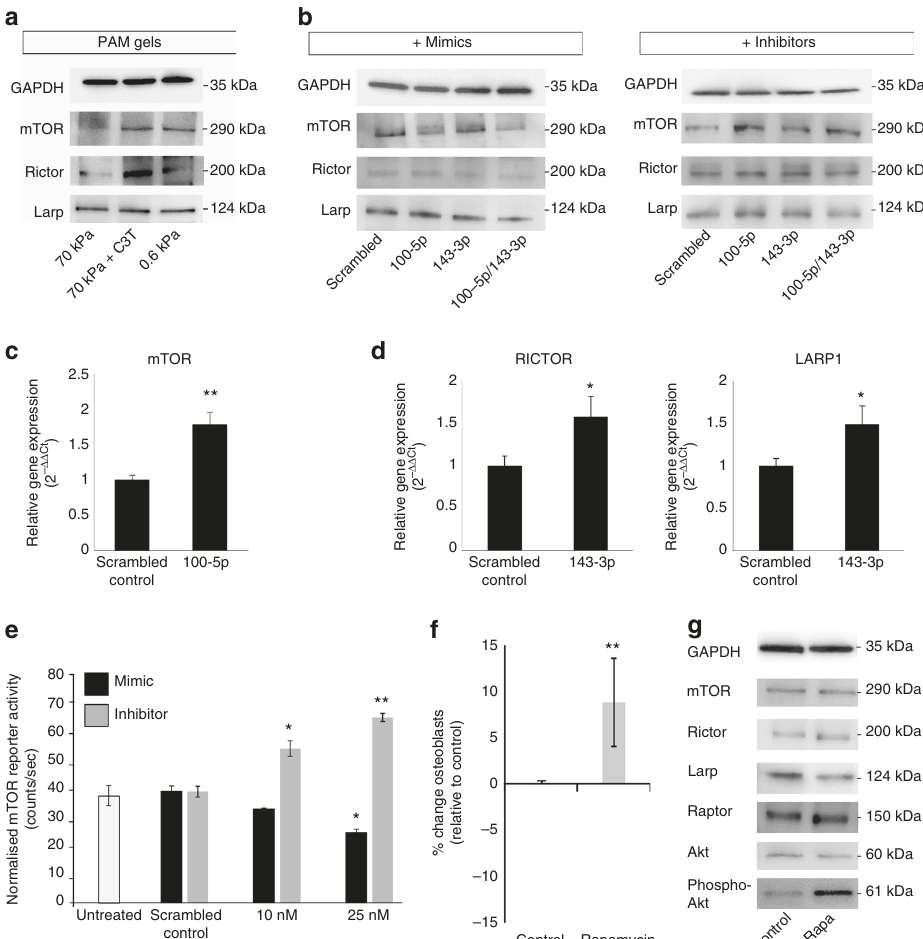
Fig. 4 miR-100-5p and miR-143-3p converge on mTOR signalling. a Western blots of miRNA targets in response to substrate stiffness. b Western blots of miRNA targets in hMSCs treated with miRNA mimics and inhibitors. c qPCR determination of the relative expression of miRNA target genes in hMSCs treated with miRNA inhibitors for miR-100-5p and d miR-143-3p . Samples were analysed by one-way ANOVA with Games-Howell post hoc testing. e 3 ′ UTR reporter assay for FRAP1 (mTOR) in hMSCs transfected with mimics (black) and inhibitors (grey) of miR-100-5p . f Differentiation switch assay of MSCs treated with 50 nM rapamycin. Data is shown as mean ± SD of the change in proportion of osteoblasts. g Western blots of mTOR pathway components in hMSCs treated with 50 nM rapamycin. All graphs show mean ± SD for three independent hMSC donors relative to expression in control samples. Samples were analysed by one-way ANOVA with Tukey post hoc testing. Statistically different samples are denoted by * p < 0.05, ** p < 0.01 and *** p <